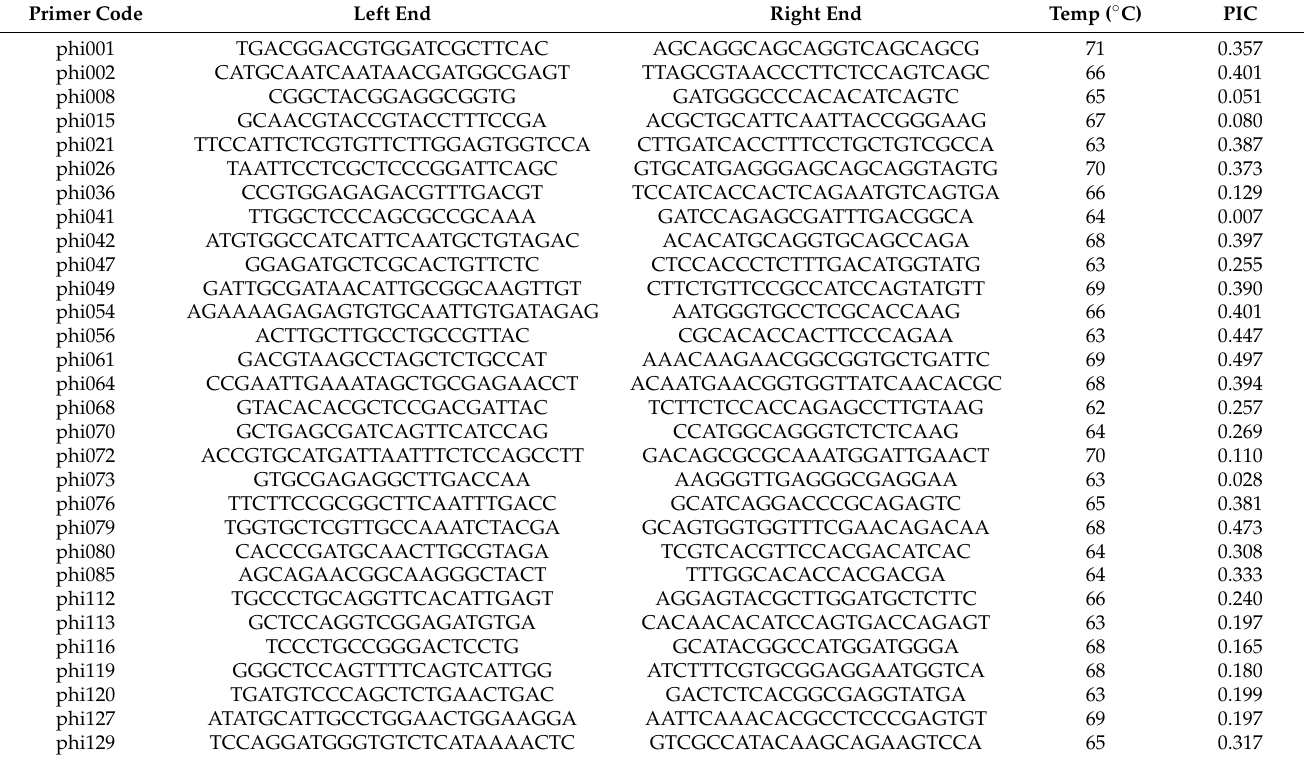
Table 1. Code and sequences of primers tested, with annealing temperature and the polymorphic information content (PIC). Primer